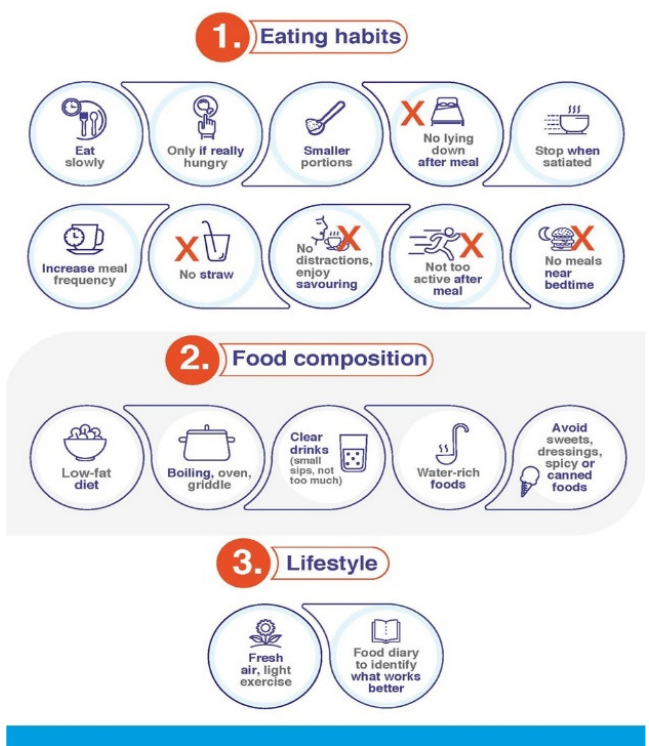
Figure 1. Minimizing occurrence/severity of GI AEs: patients general guidelines.